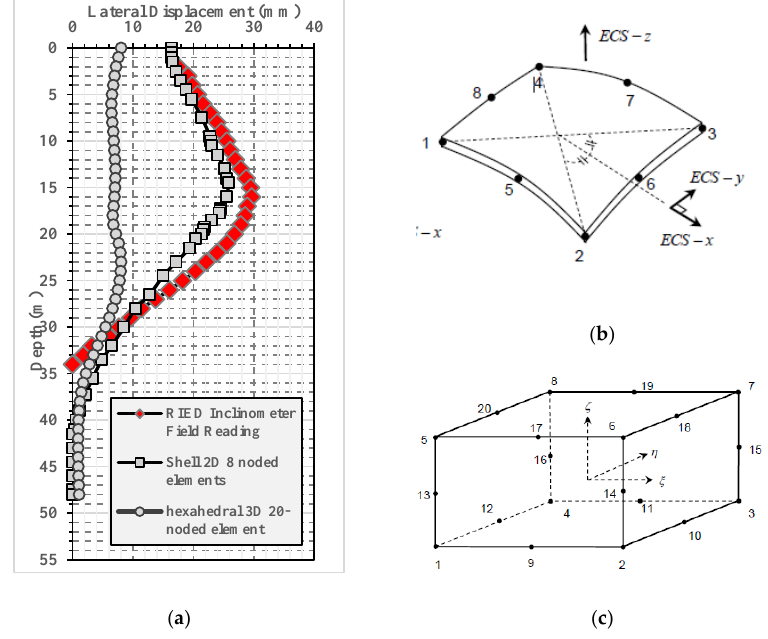
Figure 9. ( a ) Comparison between wall lateral displacement results obtained using two di ff erent methods of wall simulation. ( b ) Two-dimensional shell element (8-noded) [37]. ( c ) Three-dimensional hexahedral element (20-noded)